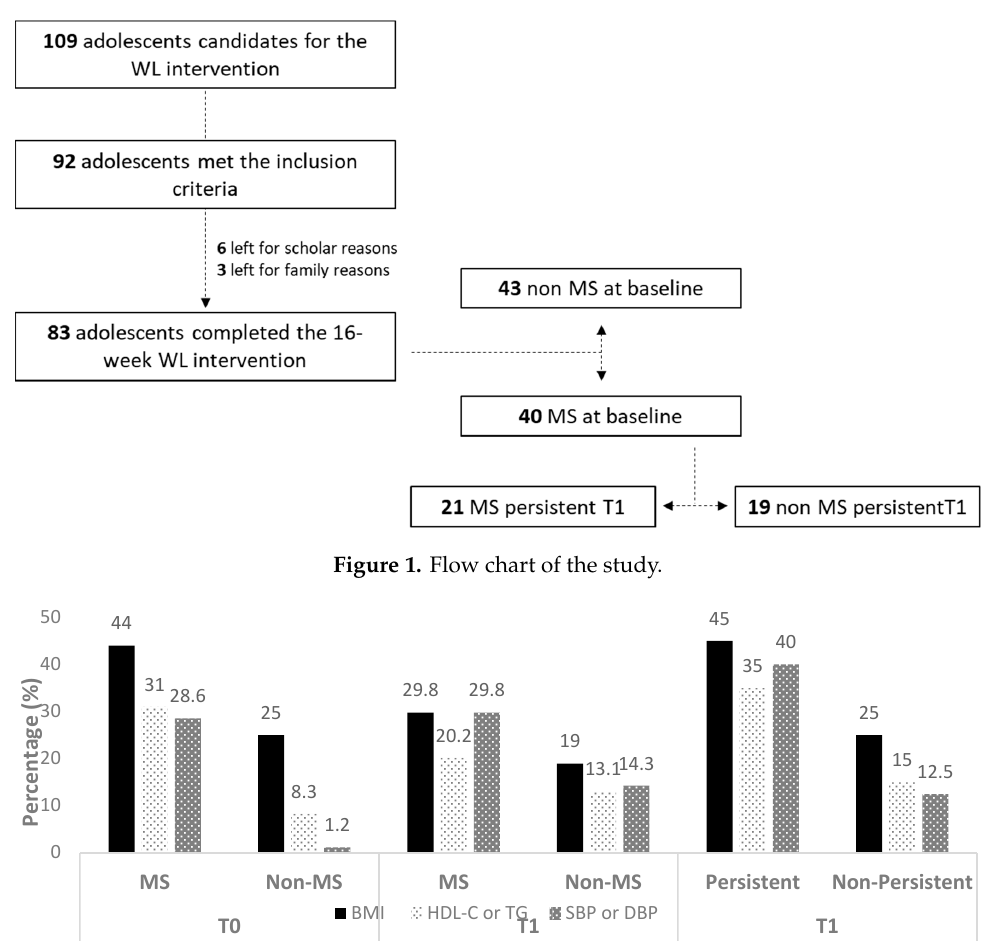
Figure 1. Flow chart of the study.